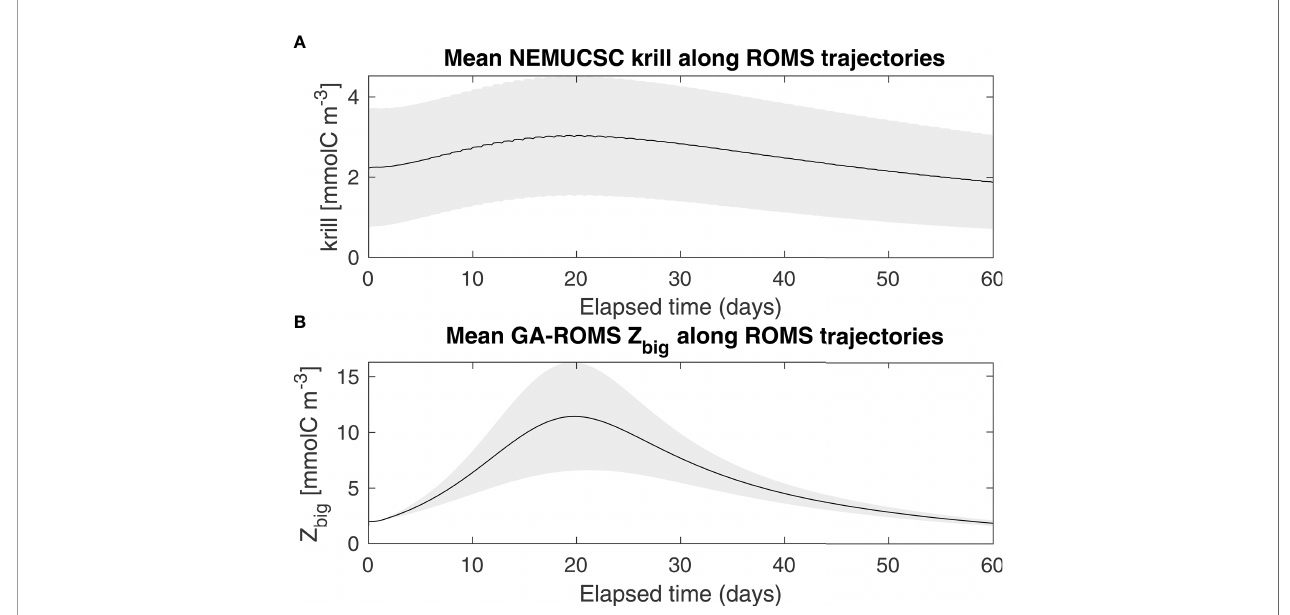
FIGURE 2 | Averaged krill concentration along ROMS trajectories, as represented by NEMUCSC-traj (A) and GA-ROMS (B) , originating between 34-44°N between April and